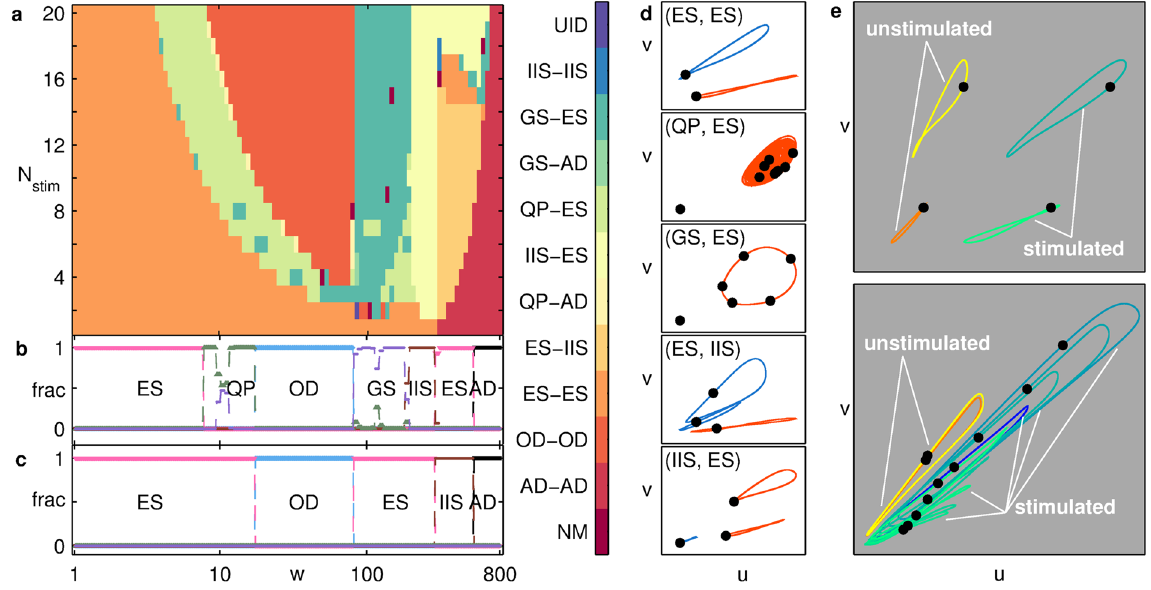
Figure 3. ( a–d ) Collective dynamics of a system of N = 20 globally coupled nodes for I u = 1.25. ( a ) Different synchronization states obtained by varying the number of stimulated nodes, N stim , and coupling strength, w , with ( P stim , P unstim ) referring to patterns in stimulated and unstimulated groups. The colors represent the collective pattern (indicated in the colorbar) obtained for more than 50% of random initial conditions. When no pattern forms a majority, the region is indicated by NM (“no majority”), and UID (“unidentified”) indicates that the nature of the pattern was not detected by the order parameters. ( b,c ) Variation of the attraction basin size (measured as fraction of initial states reaching the attractor) with w at N stim = 10 for the different regimes in ( a ), shown separately for the ( b ) stimulated and ( c ) unstimulated groups. Basin sizes have been estimated using 10 2 initial conditions. ( d ) Phase space projections of the trajectories (red: stimulated, blue: unstimulated) corresponding to the different synchronization states indicated in ( a ). ( e ) Phase space projections for the pattern (IIS, IIS), corresponding to a dynamical chimera state, obtained for the case N = 21, N stim = 18, w = 300, in a globally coupled system [ k = 20, top] and in a relatively sparse network [ k = 16, bottom]. The trajectories of the stimulated and unstimulated nodes are indicated in each case. It can be seen that as the network becomes increasingly sparse, individual nodes begin to trace distinct trajectories, thus amplifying the chimera nature of the state.